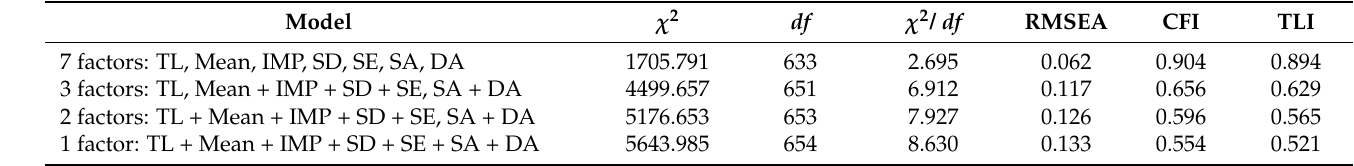
Table 2. The results of confirmatory factor